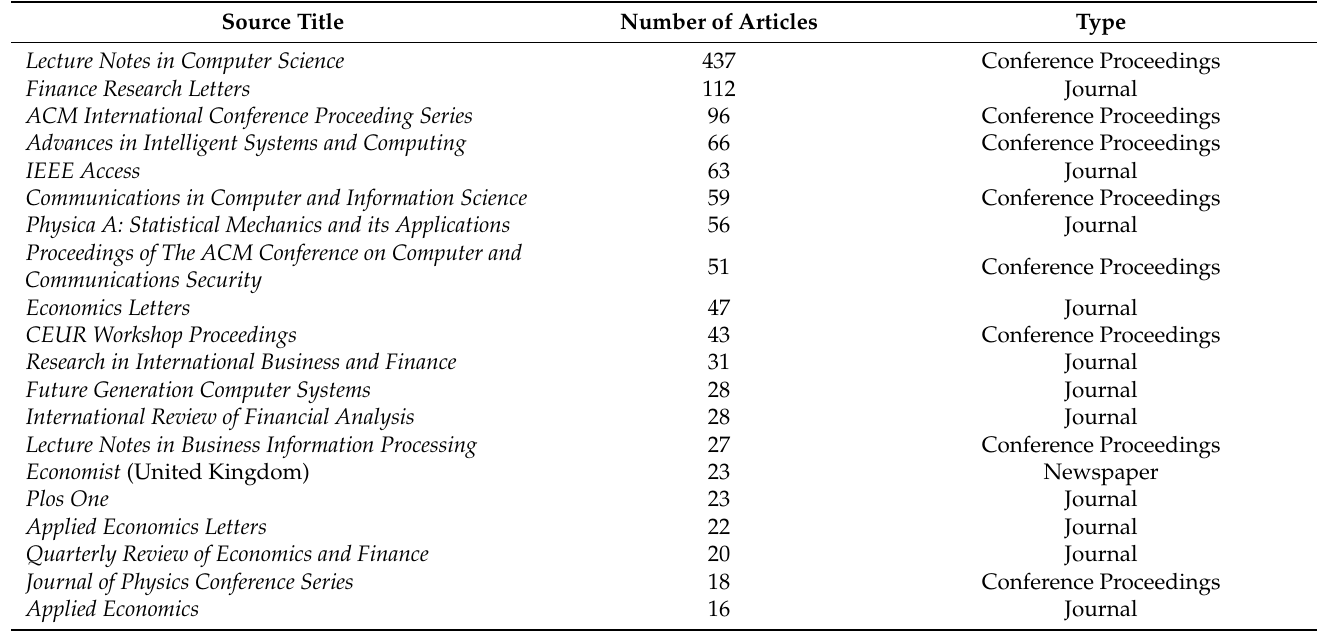
Table 5. Most important sources of Bitcoin